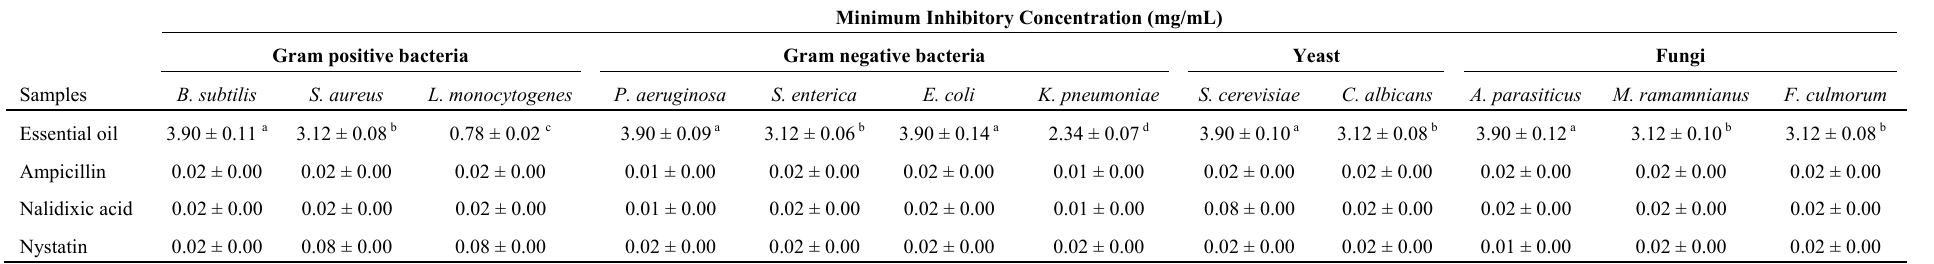
Table 4. Minimum inhibitory concentration for E. gilii essential oil.